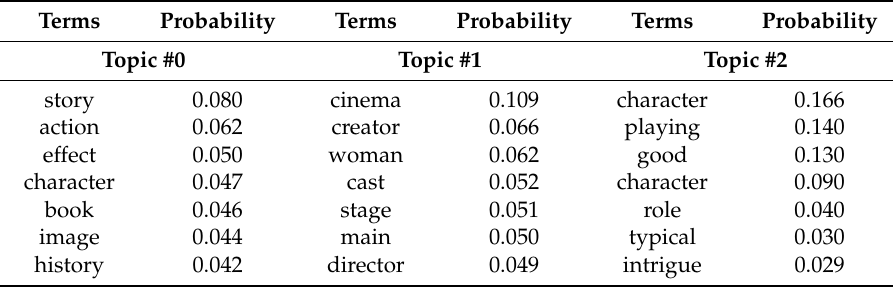
Table 2. List of Latent Probabilistic Topics with Distribution of Terms.